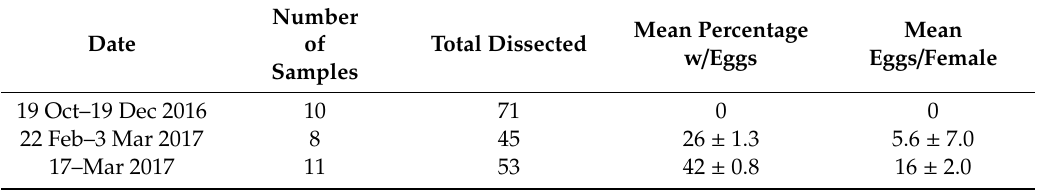
Table 2. Mean percentage of dissected females with eggs and eggs per female sub-sampled from aggregations collected during winter and